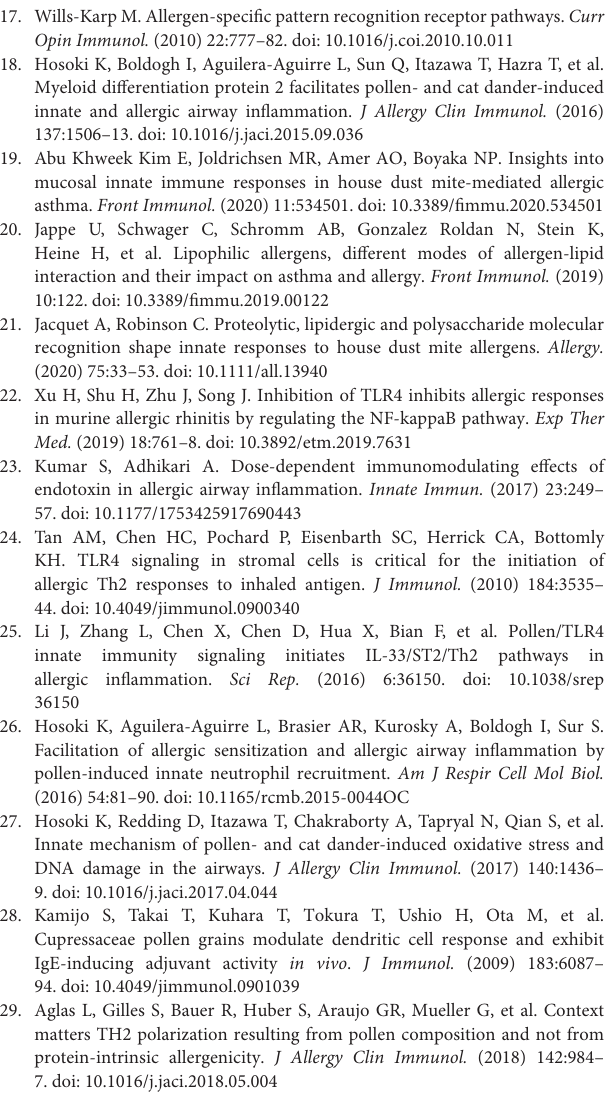
artifacts outside the analysis range, positive populations were analyzed in histograms for each marker (CD40, CD86, CD80, Jagged-1, OX40L, and FAS) (B) . Gating strategy for the TLR4 surface expression analysis was based on the unstained and TLR4-KO controls (C) . Supplementary Figure 8 | Interpolation using linear regression for the quantification of the Bet v 1 level in BPE via sandwich ELISA (A) . BPE titration (based on the total protein concentration) and the Bet v 1 standard curve are represented in green and blue, respectively. A concentration of 1 mg/ml BPE contained 0.125 mg/ml Bet v 1, representing about 12.5% of the total protein content in BPE. IL-2 levels measured in the culture supernatant of 60 µ g/ml BPE-stimulated BMDCs seeded at a cell density of 2 × 10 5 cells per well (B) . Data represent the pooled, normalized data of five individually performed BMDC activation assays, with the medium control set to 1. Supplementary Table 1 | Characteristics of the blood donors. Demographic information including the sex and the age, the allergic status, as well as the total IgE level (kU/L) and the sensitization profile of various allergic sources analyzed via ImmunoCAP tests are described for each